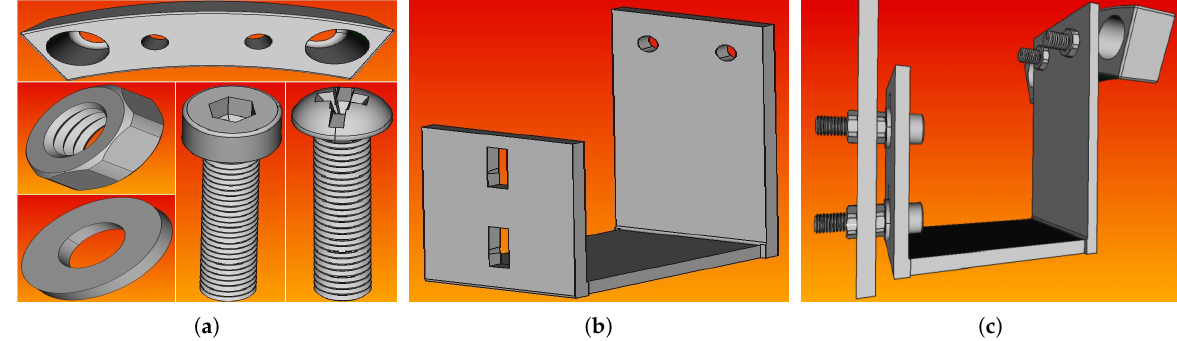
Figure 8. Designed parts of the rotating blade using FreeCAD software program: ( a ) bolts and ( b ) base, ( c ) assembled structure.